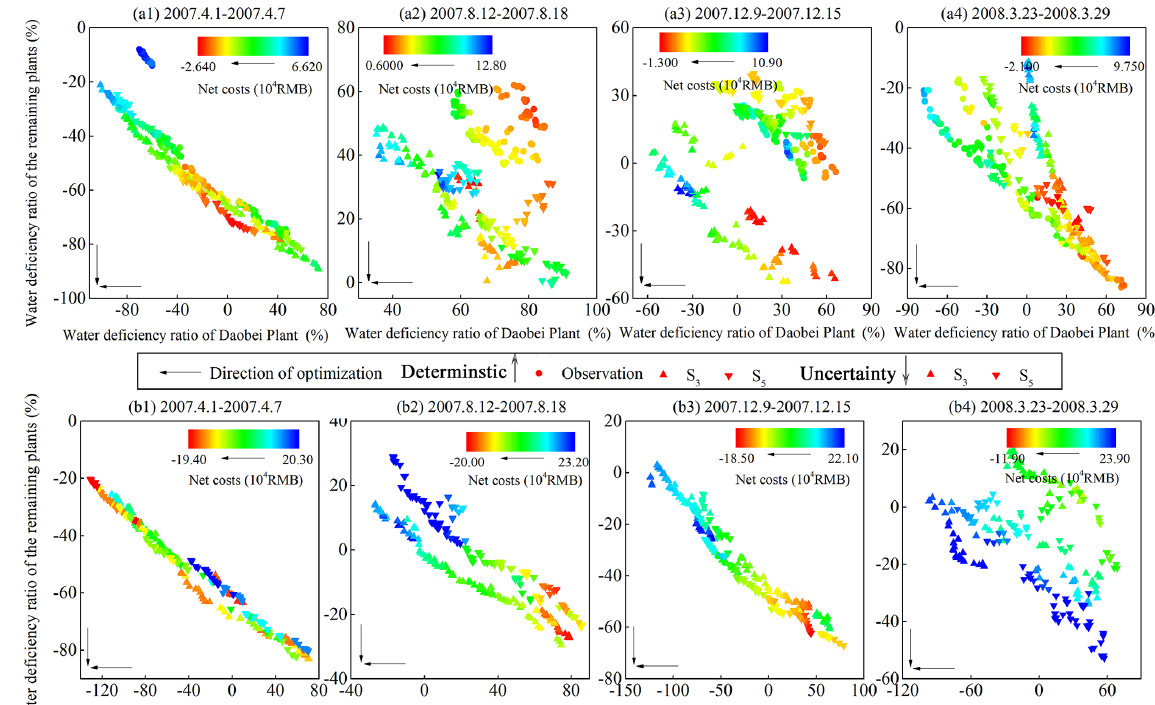
Figure 14. A set of Pareto solutions at different periods over a 7d horizon under (a) deterministic and (b) uncertain